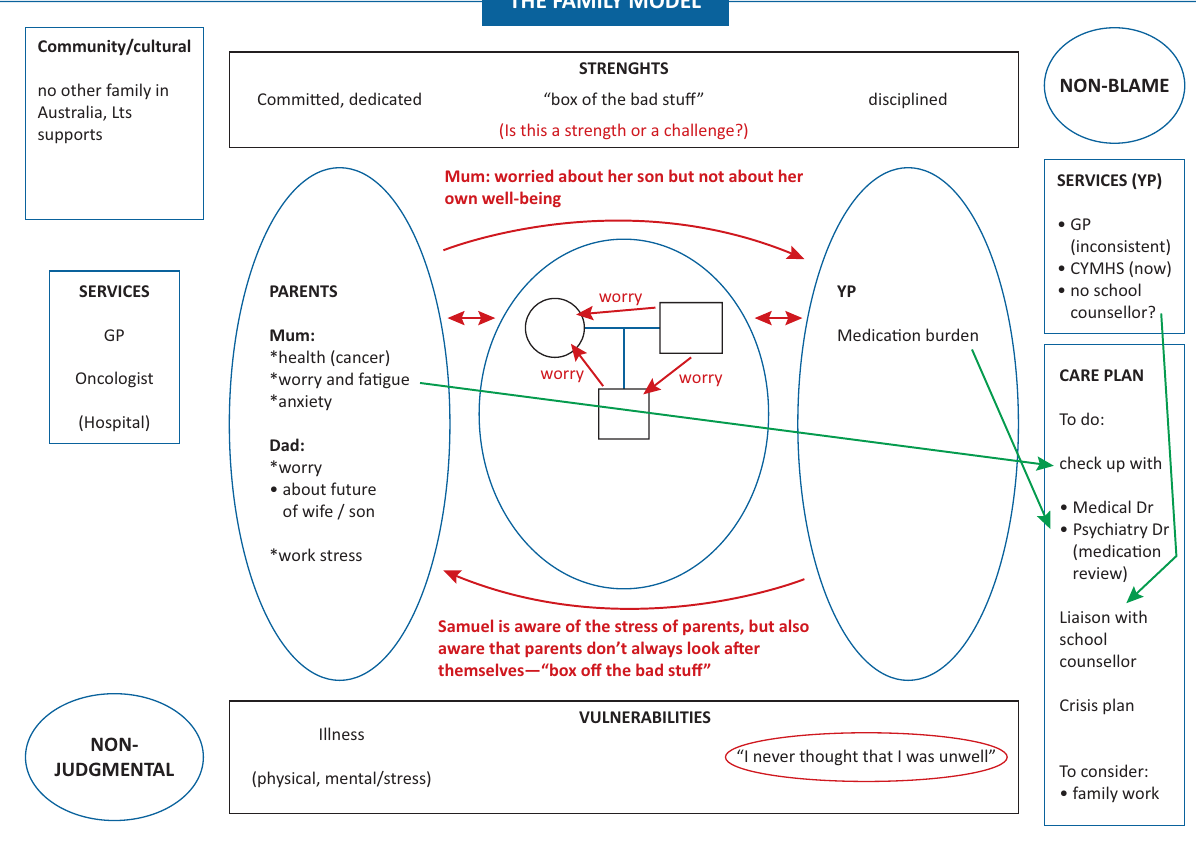
Figure 2. Outpatient